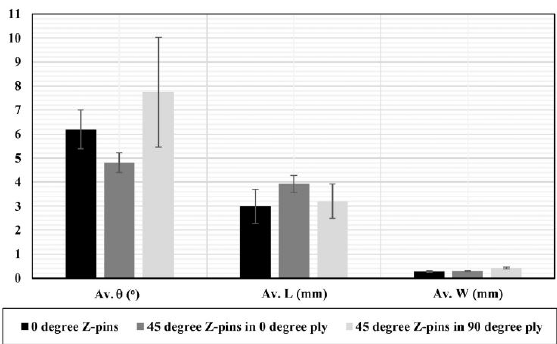
Figure 10. E ff ect of z-Pin o ff set angle on fiber waviness, length and width of the resin rich zone [17].